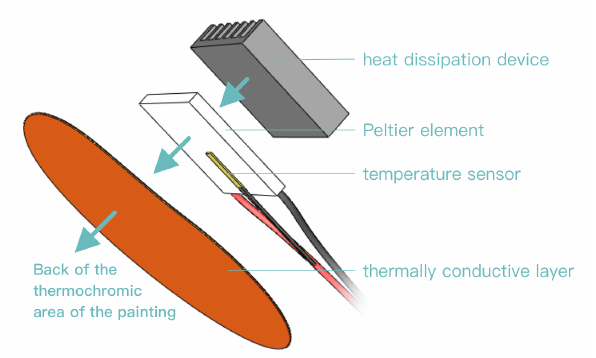
Figure 6. Structure of the temperature-changing unit (TCU). The arrows show the assembly orienta- tion of a